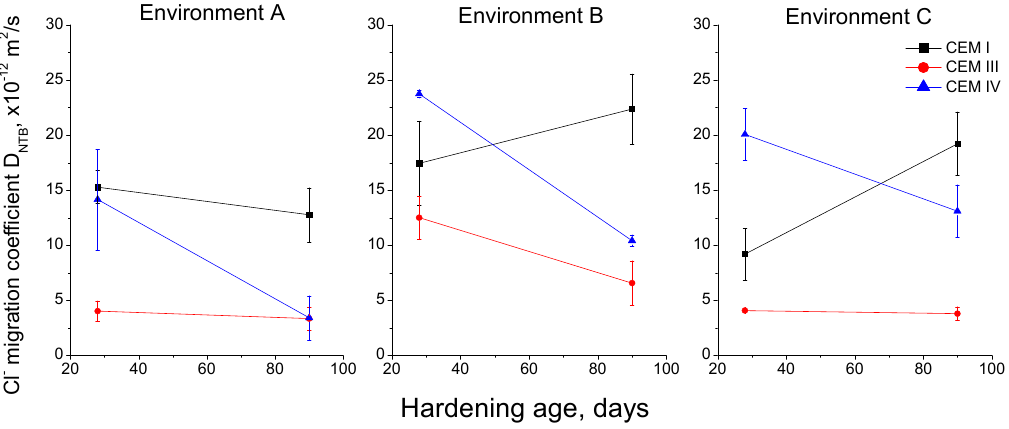
Figure 14. Results of non-steady-state chloride migration coefficient for the studied mortars.